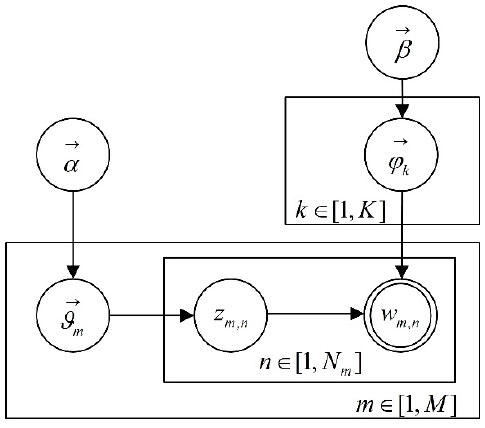
Figure 1. Latent Dirichlet allocation (LDA) model representation.